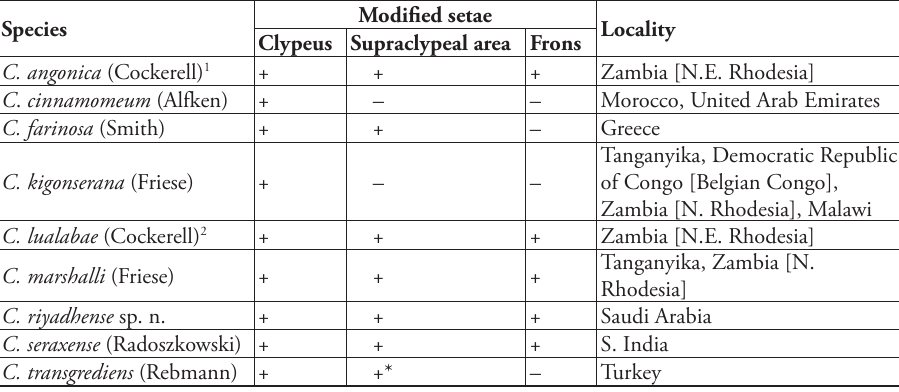
table 1. Species of Chalicodoma Lepeletier de Saint Fargeau subgenus Pseudomegachile Friese with modi- fied facial setae for pollen collection from nototribic flowers. Modified setae refer to simple, erect or pro- clinate, apically curved setae. Plus (+) and dash (–) symbols indicate presence or absence of a character; * = not distinctly modified. In C. riyadhense sp. n. the modified setae are also found on the upper paraocular area. The locality corresponds to the areas where the examined specimens were collected, not the total distribution of those species. It must be noted that Chalicodoma (from Gr. χάλιξ , χάλιχος , calx + δω μ α , domus) is of neuter gender, and all names now referred to that genus have been made to conform. The derivation of the name was indicated by Brullé (1832), who gave: “ nom tiré de l’habitude de l’insecte, qui construit son nid avec de petits cailloux, comme Réaumur nous l’a fait connaître dans ses intéressants mémoires ”. However, only those names which are latinized adjectival or participial species-group names are adjusted in gender (ICZN 1999: Art. 34.2), which means that the forms “angonicum”, “farinosum”, and “kigon- seranum” which have appeared in various sources are all improper emendations.